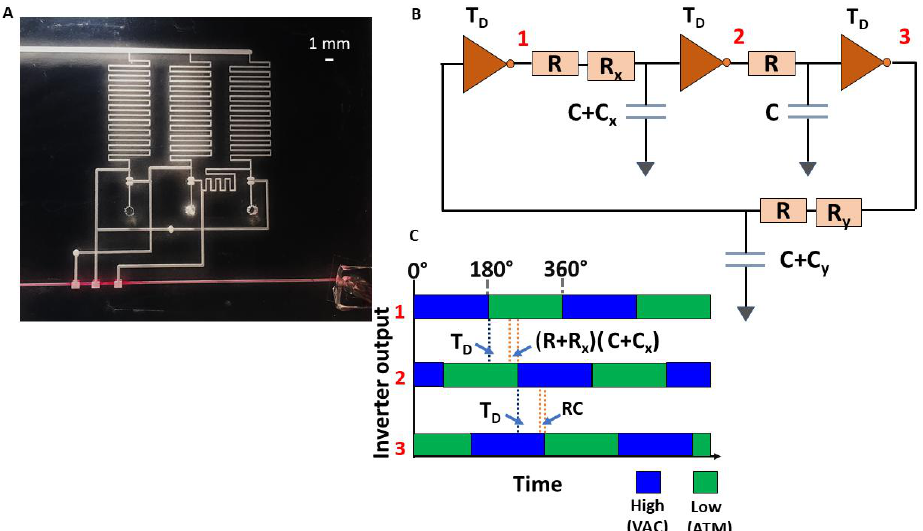
Figure 7. ( A ) Oscillator driving three valves in series out-of-phase in a fluid line. ( B ) Equivalent circuit for ring oscillator with varying interconnect channel lengths. T D is the time delay of each inverter stage; R , C represent the resistance and capacitance, respectively, of the minimum connection line between stages; R x , C x and R y , C y represent the resistance and capacitance of the delay line of a specific length ‘ x ’ and ‘ y ’, respectively, added to the minimum connection line to obtain the necessary phase difference. In the corresponding fluidic circuit, the interconnects have negligible capacitances and the resistance primarily contributes to the phase shifts. ( C ) The phase diagram shows the shifts introduced by R , R x and how they affect the delay of the subsequent stage output.